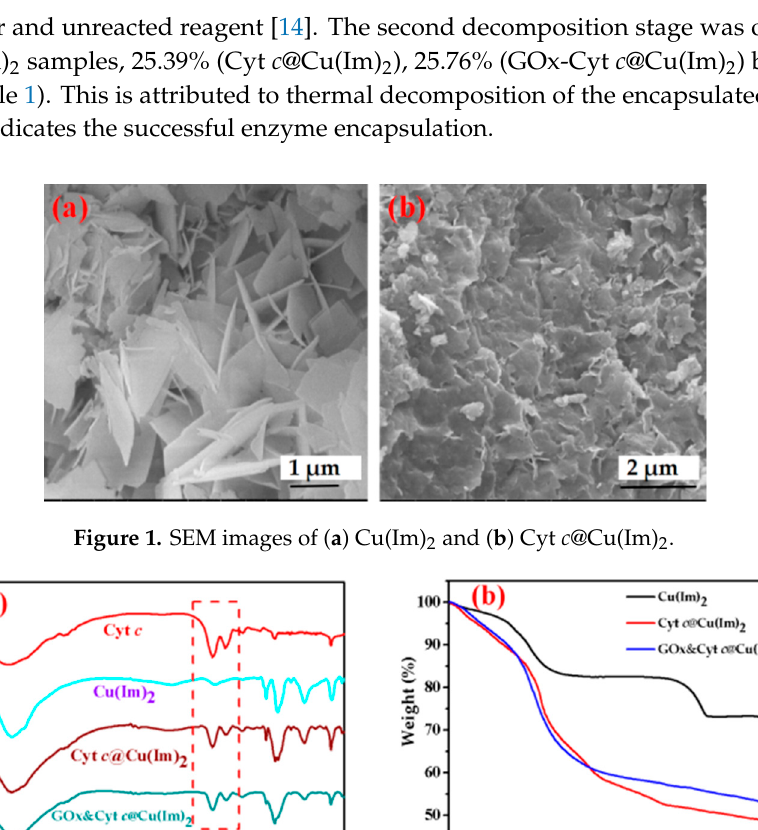
Figure 1. SEM images of ( a ) Cu(Im) 2 and ( b ) Cyt c @Cu(Im) 2 .